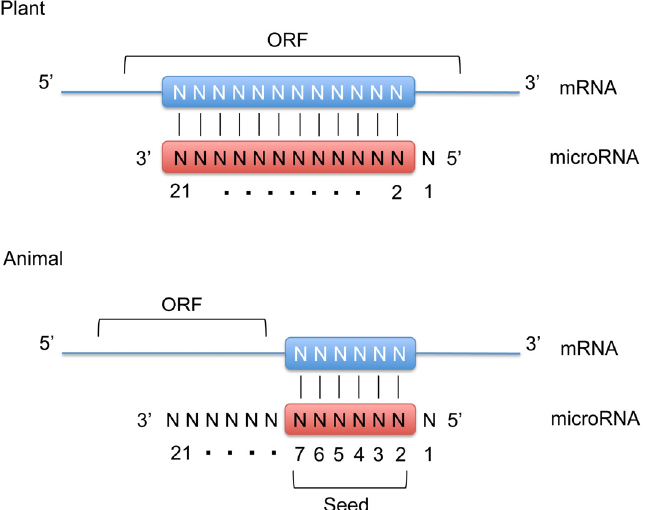
Figure 1. MicroRNA target recognition mechanism. Plant microRNAs recognize fully complementary binding sites within the open reading frame (ORF) of the target mRNA. Animal microRNAs recognize partially complementary binding sites located in the 3'-untranslated region (3'-UTR). For most microRNA binding sites, the complementarity is limited to the seed sequence containing nucleotides #2–7 on the microRNA molecule. Note that in both plant and animal microRNAs the 5'-terminal nucleotide (#1) is not involved in target